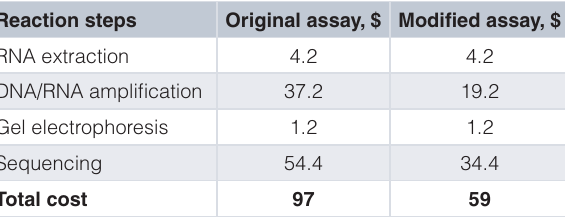
Table 6. Cost comparison at several steps of the procedure of HIV drug resistance